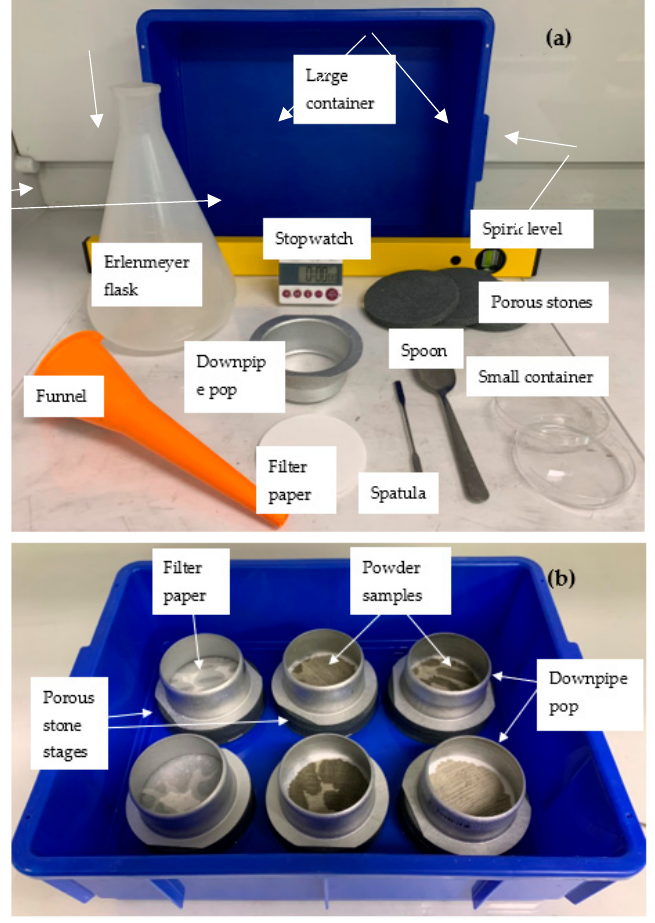
Figure 1. View of ( a ) the parts of the initial water uptake test and ( b ) hydrating samples during the test.